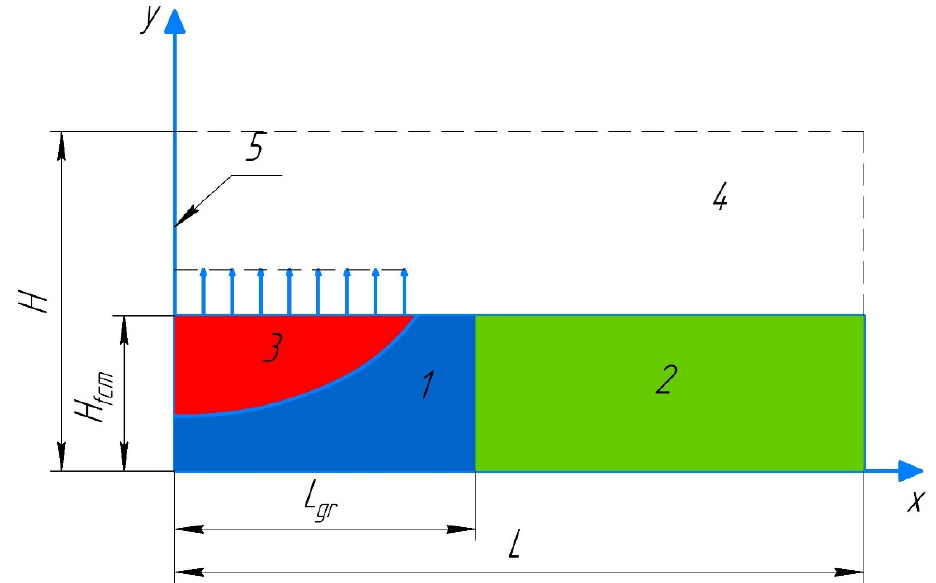
Figure 1. Scheme of solution domain 1—wetted forest fuel; 2—dry part of forest fuel; 3—drained part of forest fuel; 4—mixture of water vapors and air; 5—forest fire front.